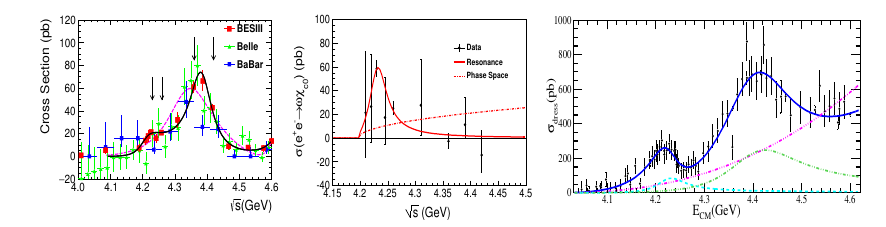
Figure 6. Cross sections of e + e − → π + π − ψ (2 S ) (left panel), ωχ c 0 (middle panel), and D 0 D ∗− π + + c . c . (right panel), as a function of c.m.